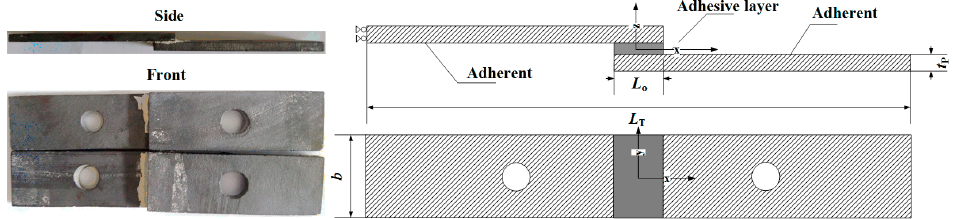
Figure 1. Geometry and characteristic dimensions of the single lap junction (SLJ). Table 1. Performance of the SiC and phosphate adhesive.